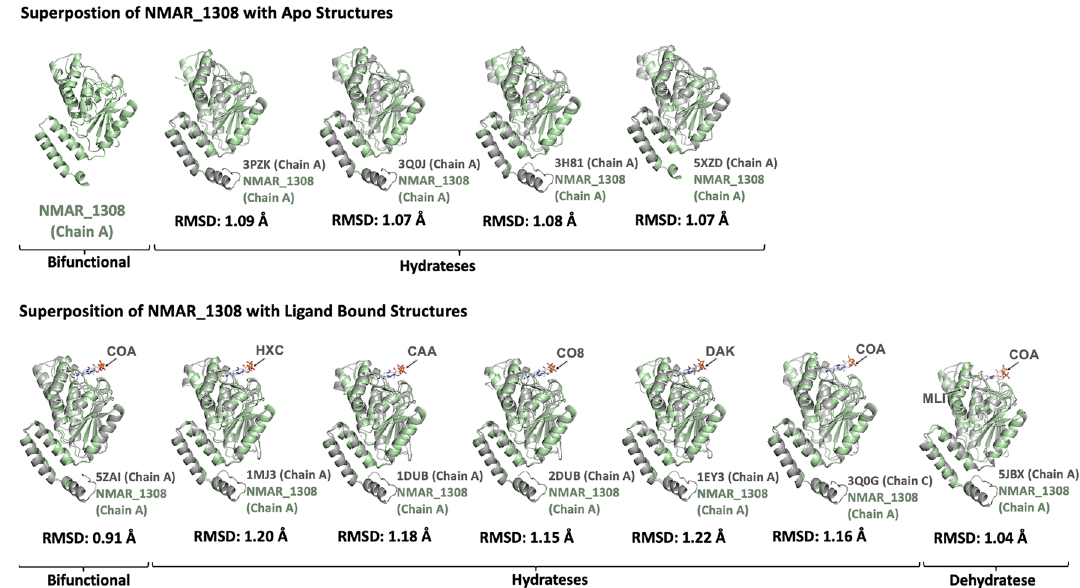
Figure 4. Superposition of Nmar_1308 with homologous structures. Superposition is performed by using cryo- synchrotron structure of Nmar_1308 with published apo/ligand bound structures of enoyl-CoA hydrates and 3-hydroxypropionyl-CoA dehydratase (3HPD). Average RMSD values were calculated from all pairwise RMSD values between Cα atoms of an Nmar_1308 monomer and one of the superimposed monomers of homologous enzymes (36 pairs for hexamers and 18 for trimers), and are indicated below each panel. All standard errors of the RMSDs are below 0.01 Å. Chain A of Nmar_1308 is colored in pale green while the superposed structure is colored in gray. The ligands were represented with arrows. The figure is generated by PyMOL (www. schro dinger. com/ pymol). (HXC: hexanoyl-CoA, CAA: acetoacetyl-CoA, CO8: octanoyl-CoA, DAK: 4-(N,N- dimethylamino)cinnamoyl-CoA, COA: coenzyme